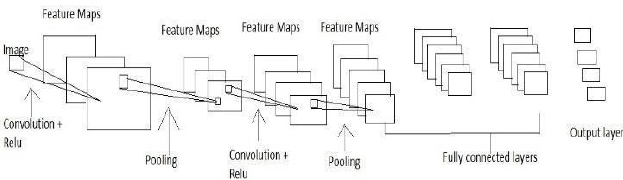
Fig 3.2: Convolutional Neural Network